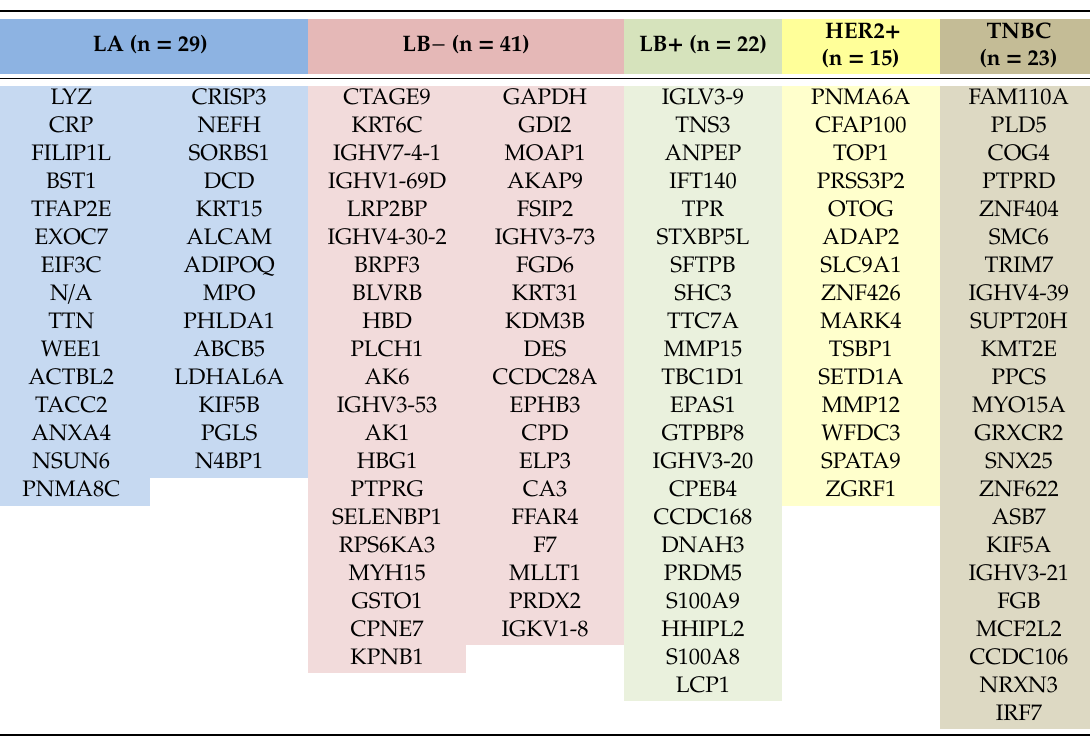
Table 2. Specific proteins for each di ff erent breast cancer subtypes (luminal A (n = 11), luminal B HER2 negative (n = 10), luminal B HER2 positive (n = 7), HER2 positive (n = 6), and triple negative) identified in the AuNPs-protein corona after the interaction of AuNP (10.02 ± 0.91 nm) (30 min, incubation) with serum samples belonging to BC